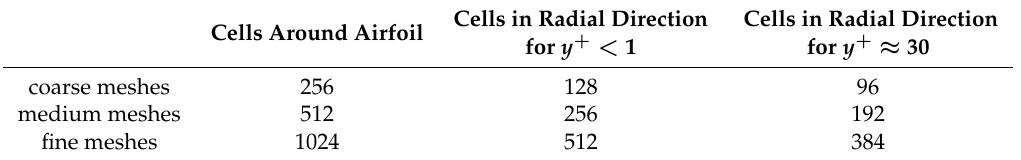
Table 1. Number of cells used in the mesh